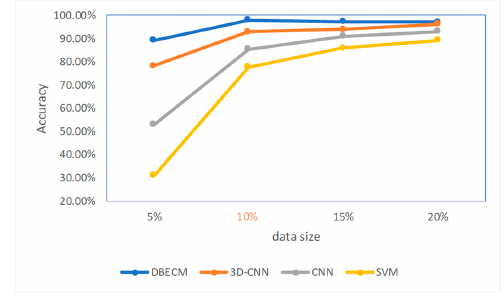
Figure 12. Indian pines dataset OA changes with the training set selection ratio.